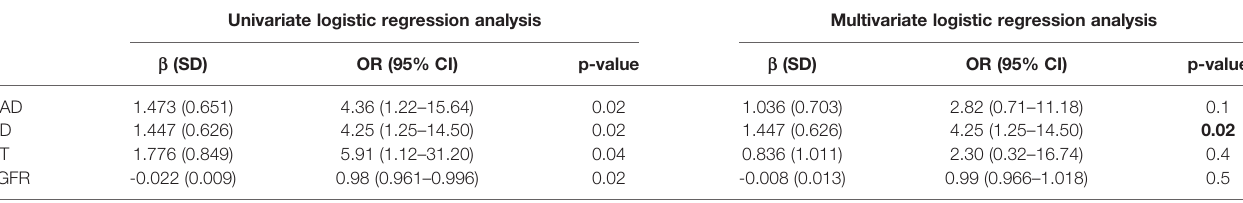
Themultivariatemodelincludedallthevariablesthatweresigni fi cantintheunivariateanalysis(coronaryarterydisease,hemodialysis,hypertension,eGFR).BasedontheAkaikeInformation Criterion (AIC), the best- fi t model was selected. On the basis of the coef fi cients b , the value of their exponents: exp( b ) was calculated, which means the unit odds ratio. SD, standard deviation;OR,oddsratio;CI,con fi denceinterval;CAD,coronaryarterydisease;HD,hemodialysis;HT,hypertension;eGFR,estimatedglomerular fi ltrationratecalculatedusingtheMDRD formula (see Materials and Methods). Signi fi cant difference are marked in